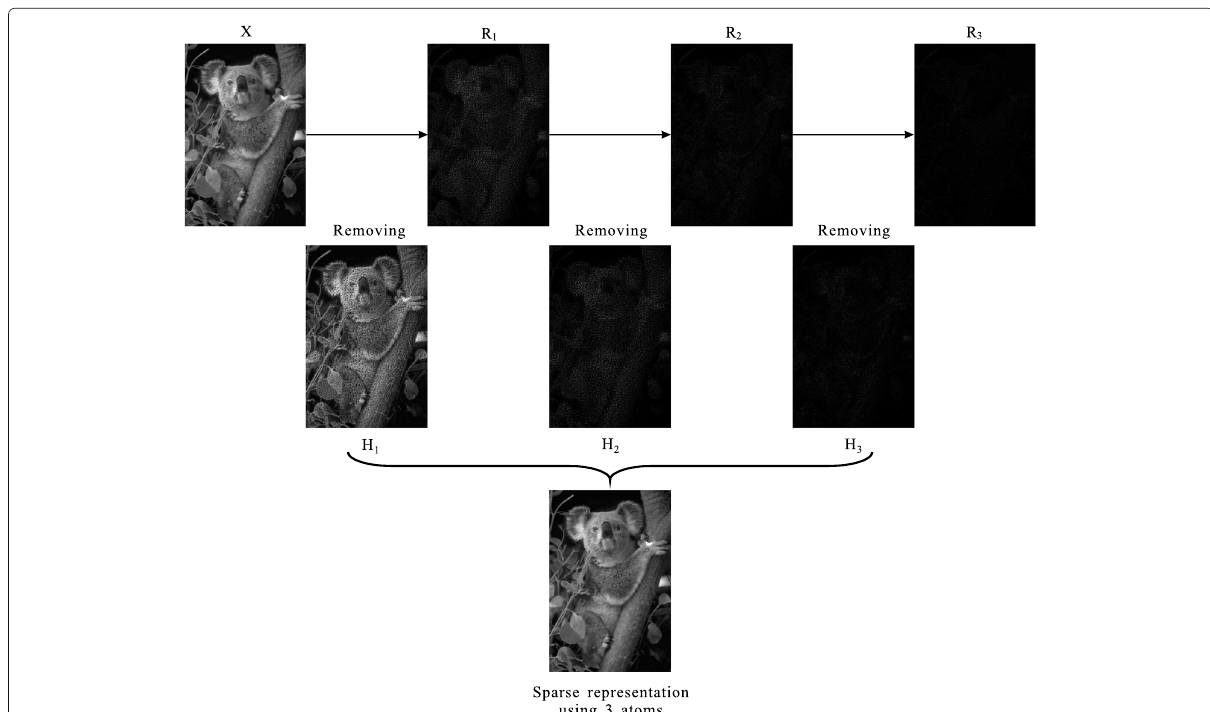
Fig. 1 The original “Koala” image, the image features of different clusters, and the residual